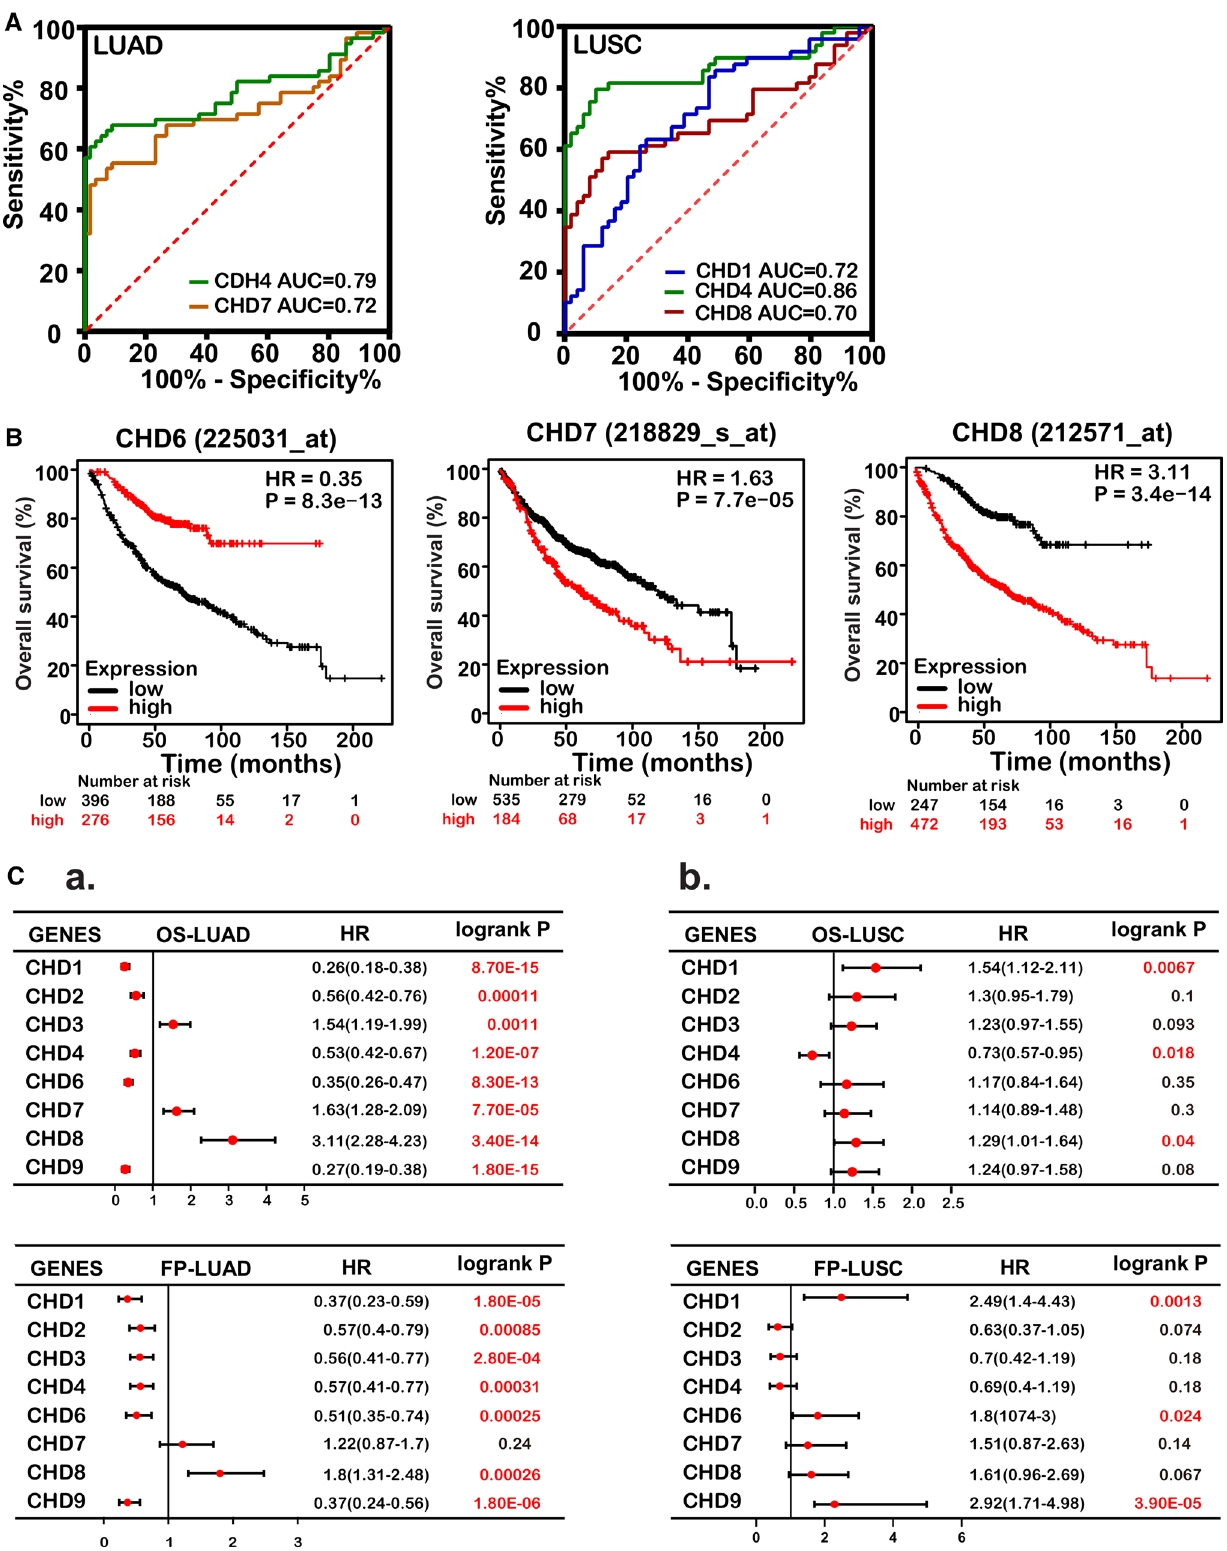
Fig. 3 The correlation between CHD expression and clinical prognosis in patients with lung cancer. A ROC analysis of CHD expression for distinguish- ing lung cancer from normal lung tissues. left panel, LUAD; right panel, LUSC; B Kaplan–Meier analysis showing that expression of CHD6/7/8 was linked to overall survival in LUAD; C a Forest plots showing the association between the mRNA expression levels of CHDs and overall survival in LUAD and LUSC; b Forest plots showing the association between the mRNA expression levels of CHDs and first progression survival in LUAD and